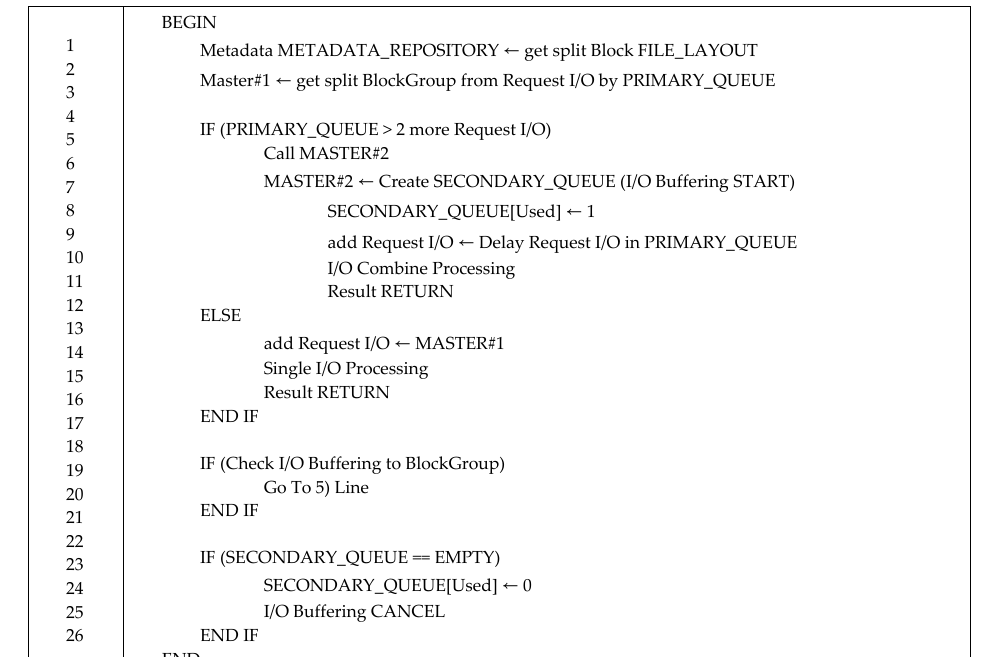
Figure 10. Method in the I/O combining step.